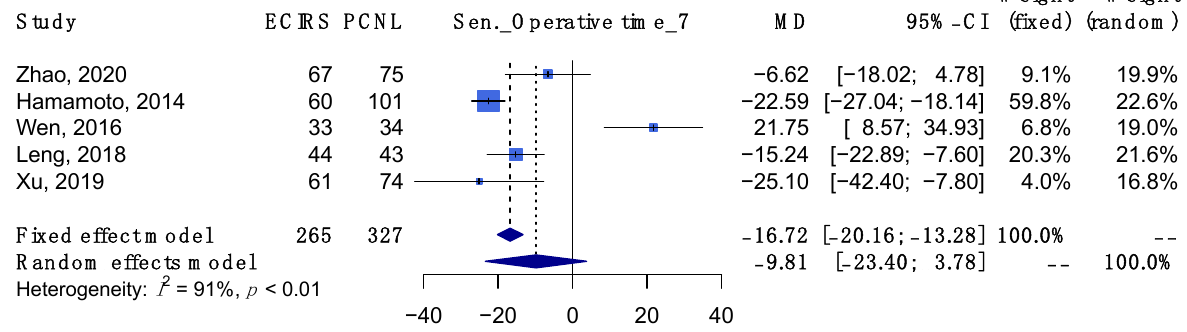
Figure A25. Sensitivity analysis of outcome regarding required blood transfusion. ([17–19,22,23])